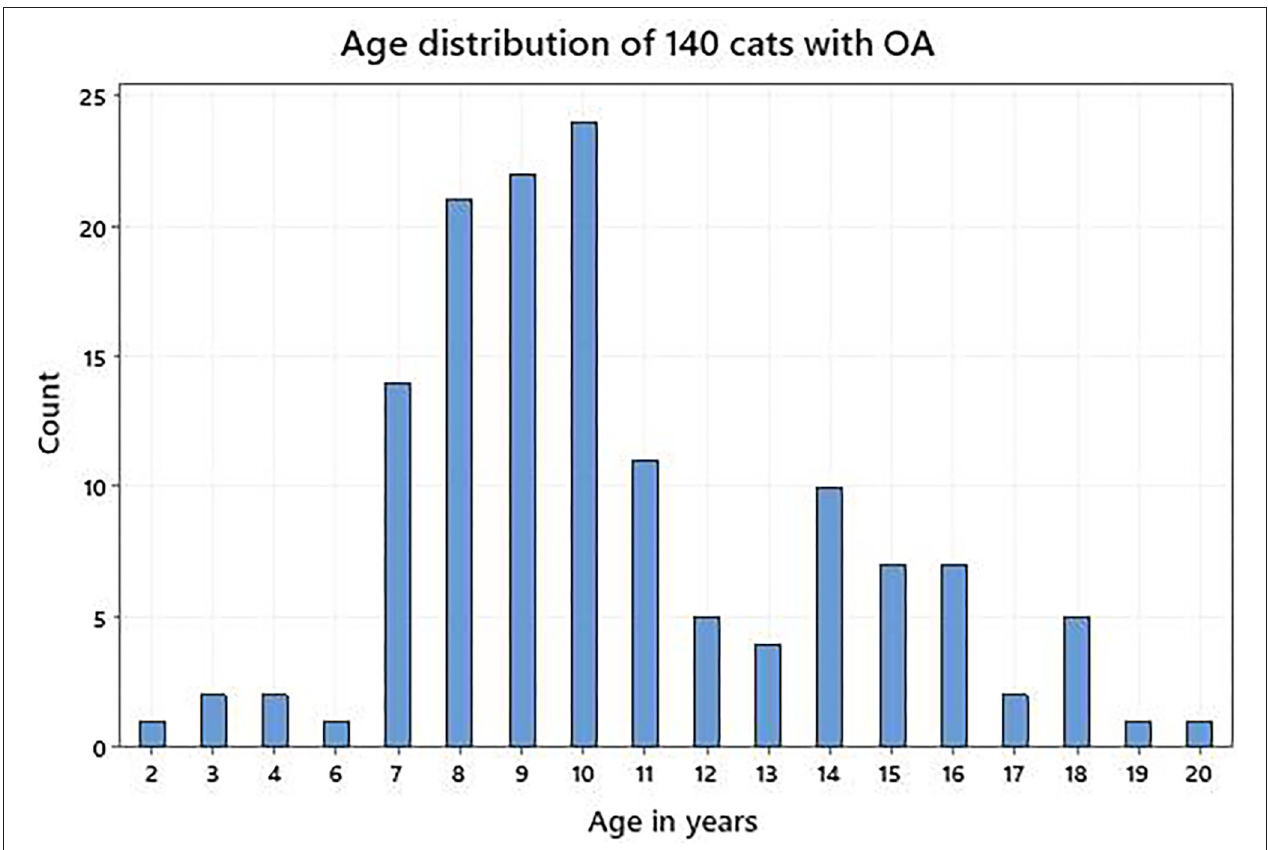
FIGURE 1 | Age distribution of 140 cat subjects with osteoarthritis.